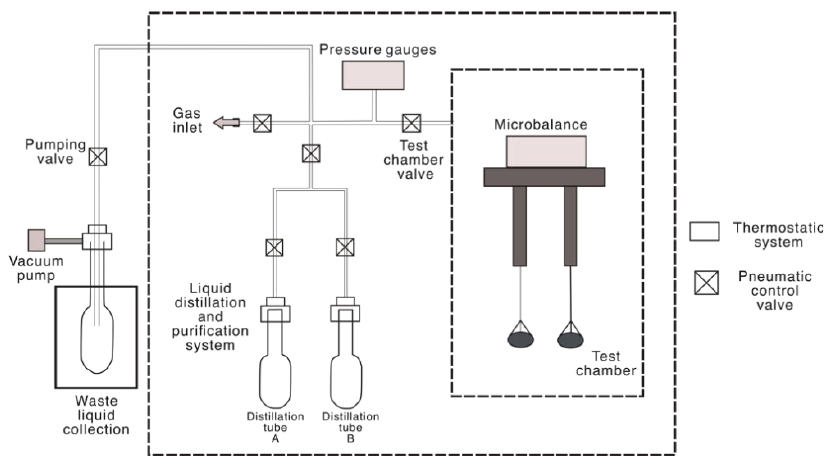
Figure 2. The 3H-2000 PW multi-station weight method vapor adsorption instrument.